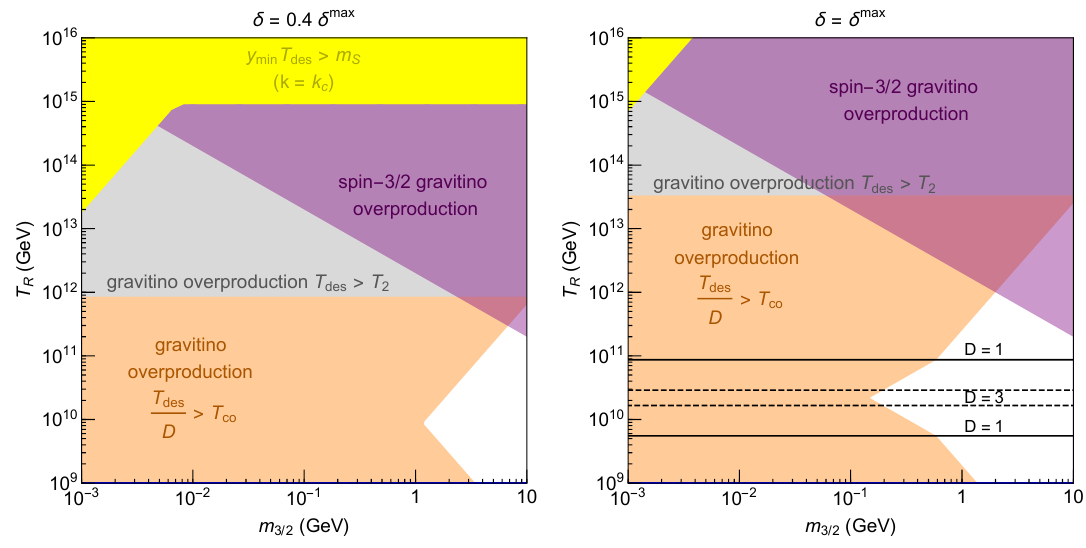
Figure 2 . The various constraints on the reheat temperature and the gravitino mass are shown as the shaded regions. These panels apply to the theories with indirect gauge mediation where the F term of S provides a small amount of supersymmetry breaking, as required in eq. (3.22). The energy of the sgoldstino condensate is transferred to radiation by thermal scattering. Leptogenesis can provide the observed baryon asymmetry in the entire allowed (unshaded) region. We take m 3 = 2 TeV and m S = 1